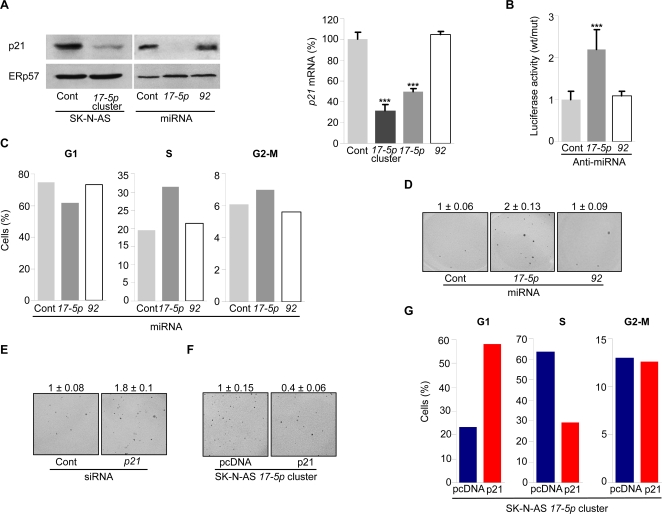
miR-17-5p mediates the oncogenic function of miRNA 17-5p-92 cluster through p21 and cell cycle regulation.(A) Western blot (left panel) and qRT-PCR (right panel) of p21 expression in SK-N-AS Cont or 17-5p cluster cells, or in SK-N-AS transiently transfected with miR-17-5p, -92 or a control miRNA. A representative Western blot is shown. Mean±s.d. (n = 3). (B) Luciferase activity in Tet-21/N cells transfected with pGL3-prom-p21UTR wt or mut in combination with a control or anti-miRNA oligonucleotides complementary to miR-17-5p or -92. The ratio of normalized luciferase activity in pGL3-prom-p21UTR wt versus mut transfected cells is indicated. Mean±s.d. (n = 6). (C) Cell cycle analysis of SK-N-AS cells transfected with miR-17-5p, -92 or a control miRNA. After transfection, cells were starved for 30 h and then incubated with a complete medium for 16 h before BrdU incorporation and FACS analysis. Percentage of cells in G1, S or G2-M phase of the cell cycle is indicated. A representative experiment is shown. (D) Anchorage independent growth of SK-N-AS cells transfected with miRNA-17-5p, -92 or a control miRNA. Cells were plated in a soft agar semisolid medium and colonies were counted after 2 weeks. In each experiment, cells were plated in triplicate. A representative field is shown. Numbers indicate the fold increase of the colony number formed by SK-N-AS transfected with miR-17-5p or -92 relative to SK-N-AS cells transfected with a control miRNA (set as 1). Mean±s.d. (n = 3); P<0.001. (E) Colony formation of SK-N-AS cells transfected with siRNA targeting p21 mRNA (p21 siRNA) or a control oligonucleotide (Cont siRNA). After transfection, cells were plated in a soft agar semisolid medium and colonies were counted after 2 weeks. In each experiment, cells were plated in triplicate. A representative field is shown. Numbers indicate the fold increase of the colony number formed by SK-N-AS transfected with p21 siRNA relative to SK-N-AS cells transfected with a control siRNA (set as 1). Mean±s.d. (n = 3); P<0.001. (F) Colony formation of SK-N-AS 17-5p cluster cells stably transfected with an expression vector for p21 or the empty plasmid (pcDNA). Cells were plated in a soft agar semisolid medium and colonies were counted after 2 weeks. In each experiment, cells were plated in triplicate. A representative field is shown. Numbers indicate the fold increase of the colony number formed by SK-N-AS 17-5p cluster cells transfected with an expression vector for p21 relative to cells transfected with the empty plasmid (set as 1). Mean±s.d. (n = 3); P<0.001. (G) Cell cycle analysis of SK-N-AS 17-5p cluster cells stably transfected with an expression vector for p21 or the empty plasmid (pcDNA). Cells were starved for 24 h and then incubated with a complete medium for 16 h before BrdU incorporation and FACS analysis. Percentage of cells in G1, S or G2-M phase of the cell cycle is indicated. A representative experiment is shown. *** P<0.001.